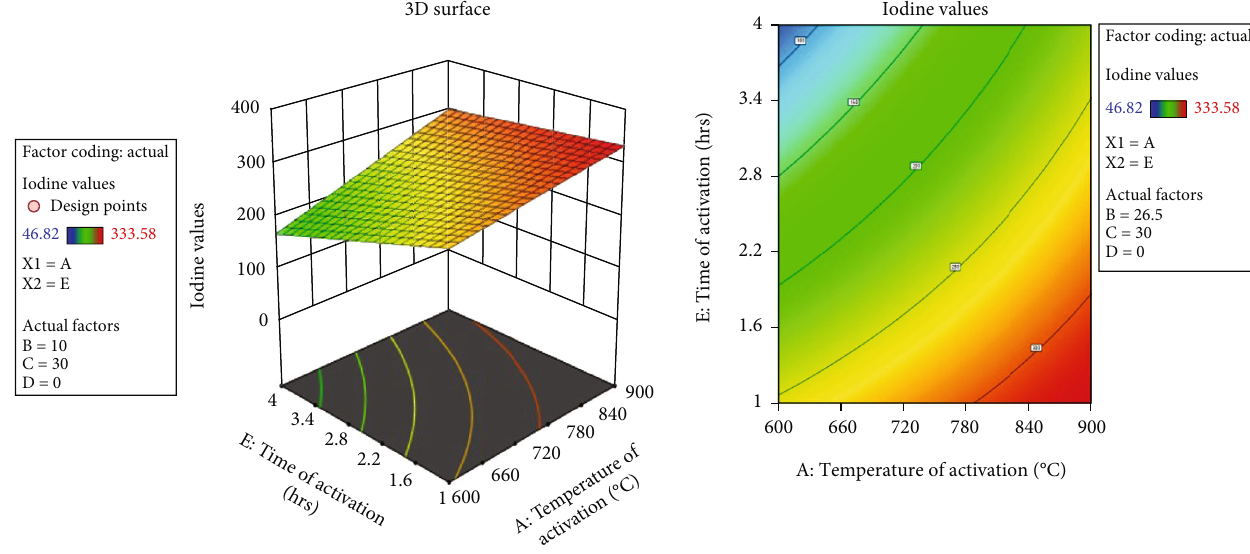
Figure 7: Surface and contour plots of the e ff ect of pulse duration based on input parameters.